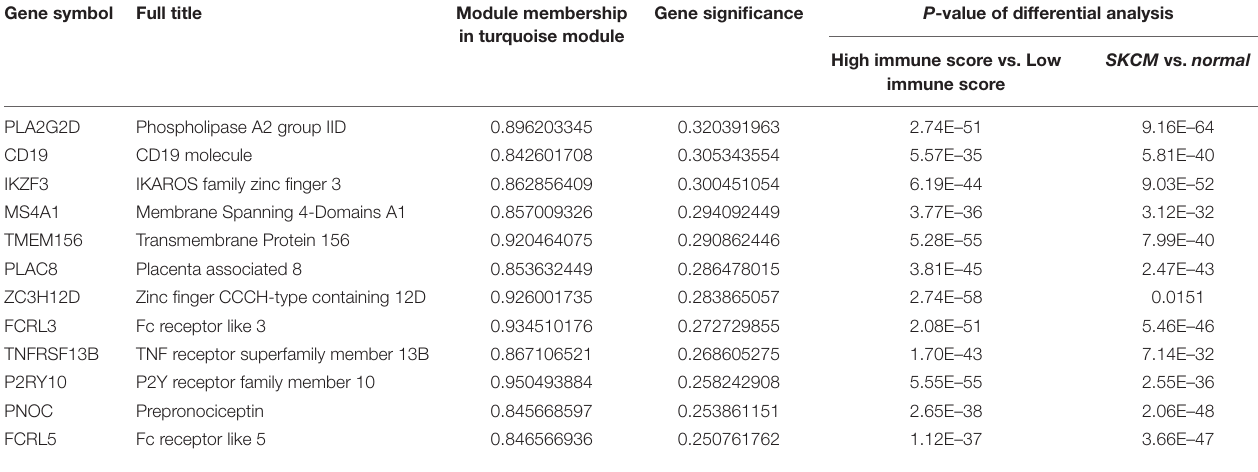
TABLE 2 | Basic information of the 12 crucial